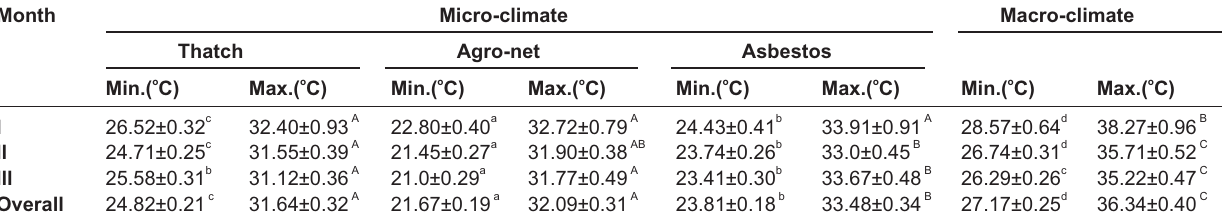
Table-1. Minimum and maximum temperature of micro-climate (under different shade materials) and macro-climate during rainy